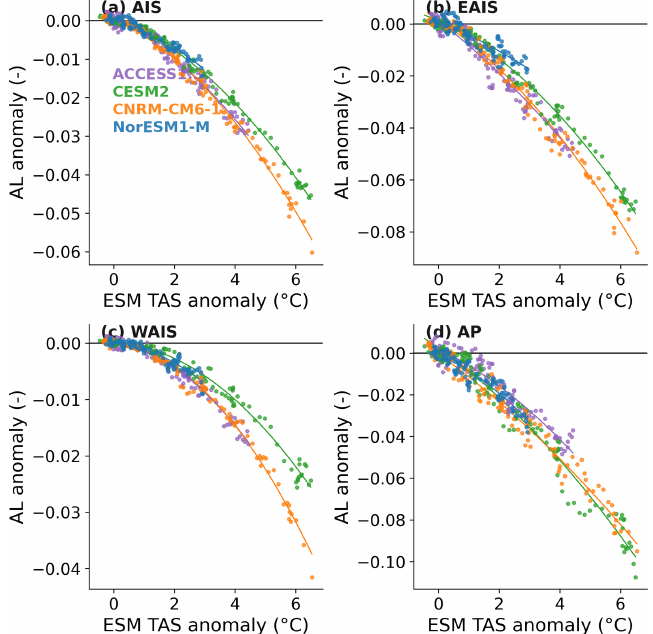
Figure 9. Changes in mean summer albedo (–) as projected by MAR forced by ACCES1.3 (purple), CESM2 (green), CNRM-CM6-1 (orange), and NorESM1-M (blue) for all the Antarctic ice shelves (a) and the ice shelves of the East Antarctic sector (b) , the West Antarctic sector (c) , and the Antarctic Peninsula (d) compared to mean summer ESM near-surface temperature ( ◦ C) over 90–60 ◦ S.